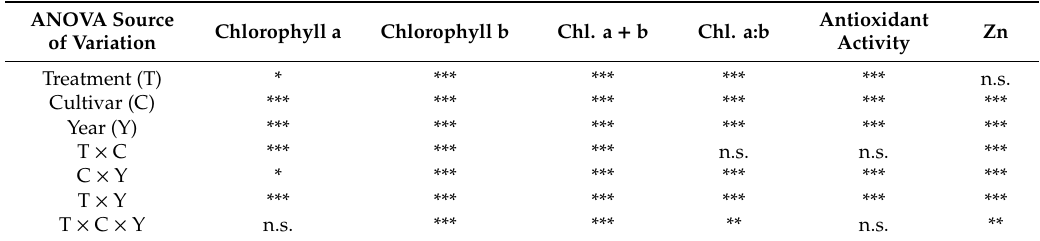
Table 1. Results from analysis of variance (ANOVA) relevant to antioxidant activity and Zn content as a ff ected by fertilizer treatment, cultivar, and year of investigation.